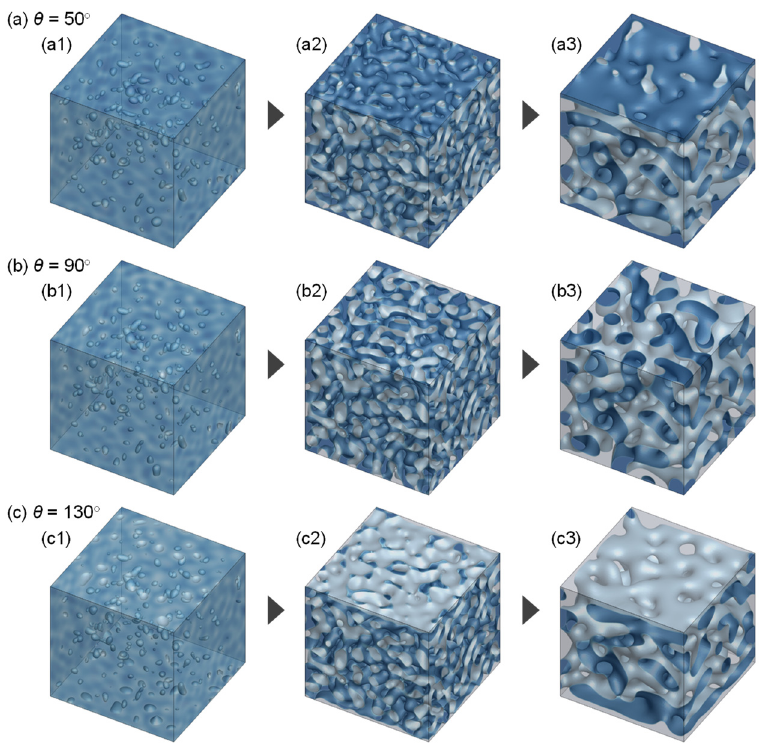
Figure 6. Growth of surface morphology. θ = ( a ) 50°, ( b ) 90°, and ( c ) 130°. The times when the snapshots were obtained were t * = ( 1 ) 0.02, ( 2 ) 0.04, and ( 3 ) 0.5 for all the cases.